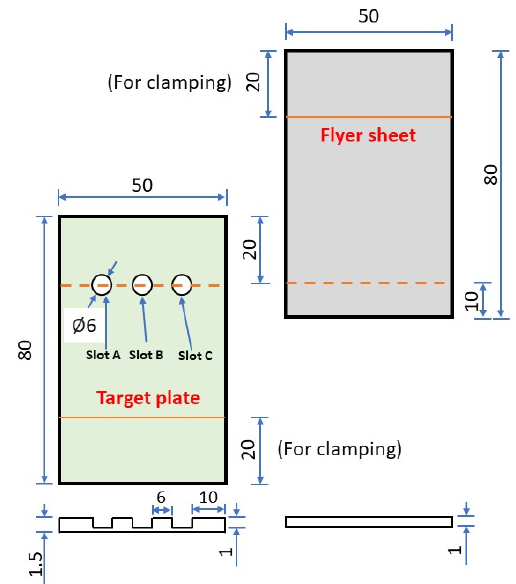
Figure 2. Materials prepared for the multi ‐ spot EMJ (dimensions in mm).